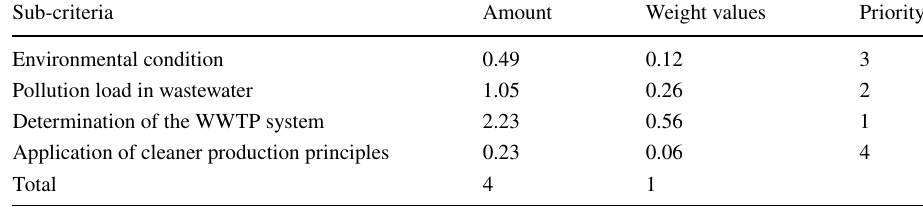
Table 7 Sub-priority weighting